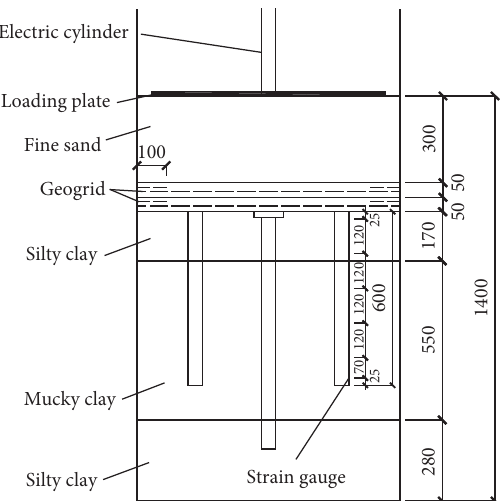
Figure 2: Vertical layout of the model test (unit: